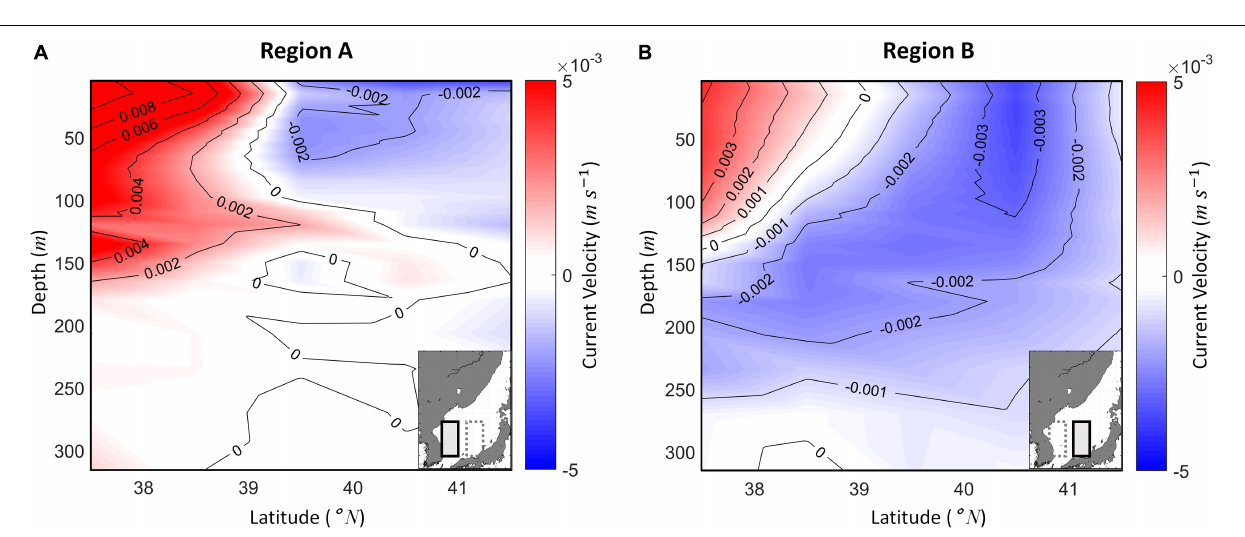
FIGURE 4 | Cross-sectional view of the difference of mean current velocity between the SWS period and the SW period (SWS-SW) in the (A) Region A and (B) Region B. Based on the same latitude, and only the longitude is adjusted to each region. The black boxes in small figures within panels (A,B) indicates the targeted area for each cross-section (gray dotted boxes indicate the opposite region). The region with blue shading indicates the transport has been weakened, and the red shading is vice